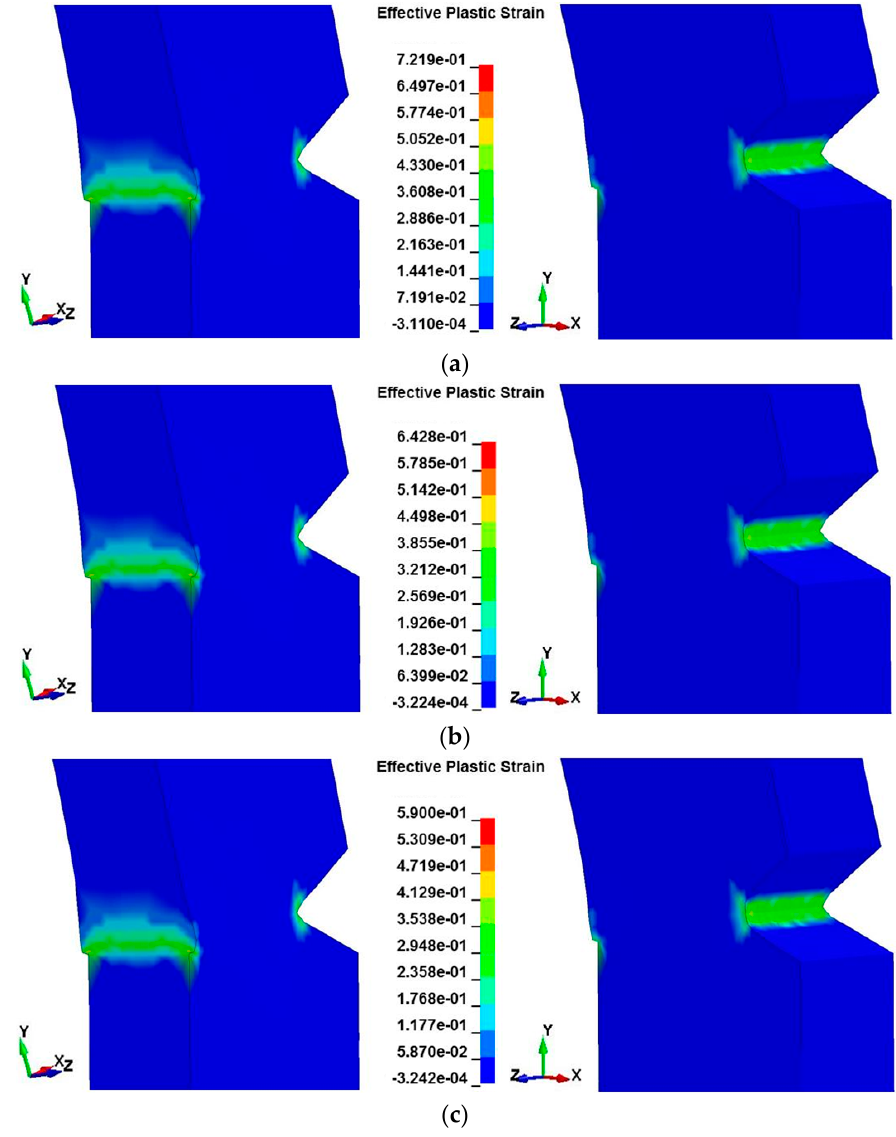
Figure 8. The distribution of plastic strain of the undamaged specimen with different model temperatures: ( a ) 60 °C; ( b ) 80 °C; ( c ) 120 °C.